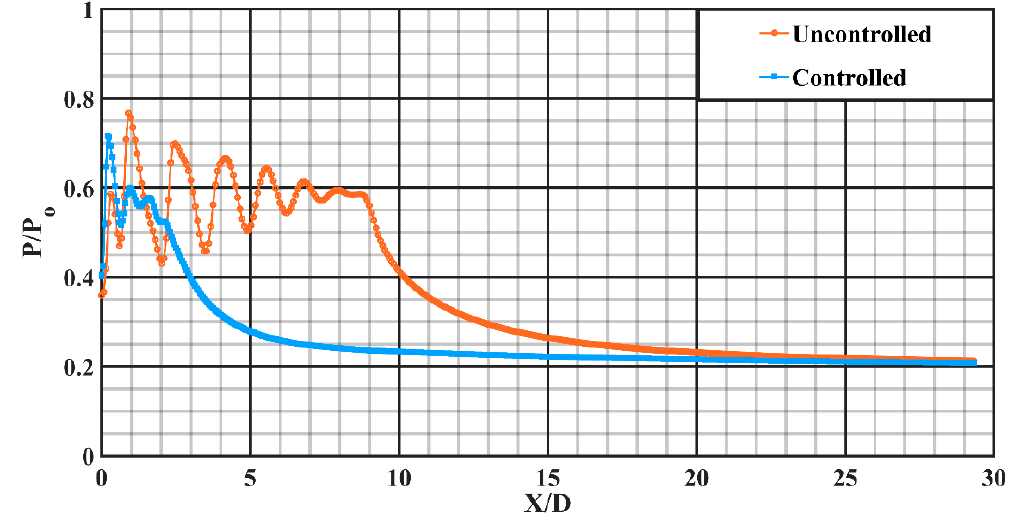
Actuators 2020 , 9 , x FOR PEER REVIEW Figure 12. Decay of Jet centerline pressure for Mach 1.8 at NPR 5. Figure 12. Decay of Jet centerline pressure for Mach 1.8 at NPR 5.